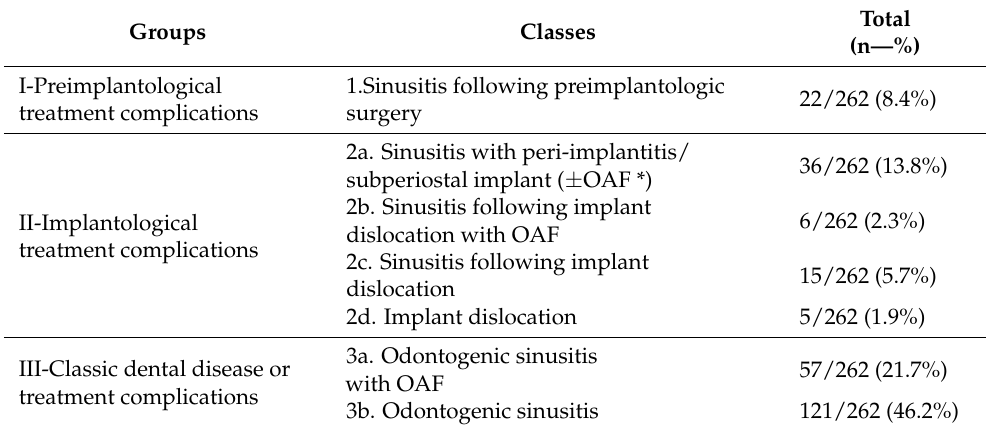
Table 2. Distribution of patients in groups and classes.